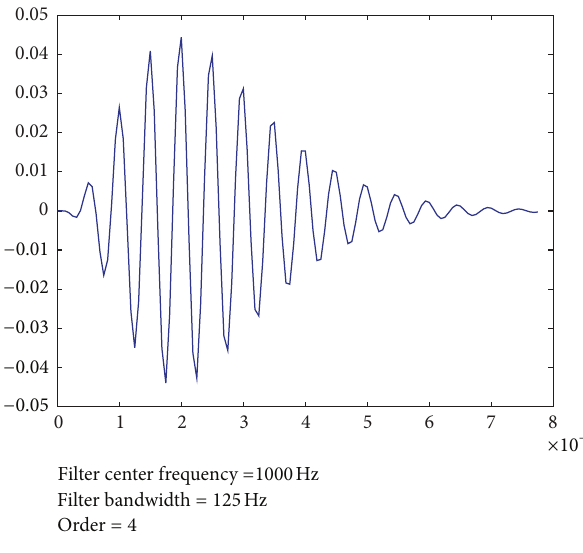
Figure 6: Gammatone function of the cochlear